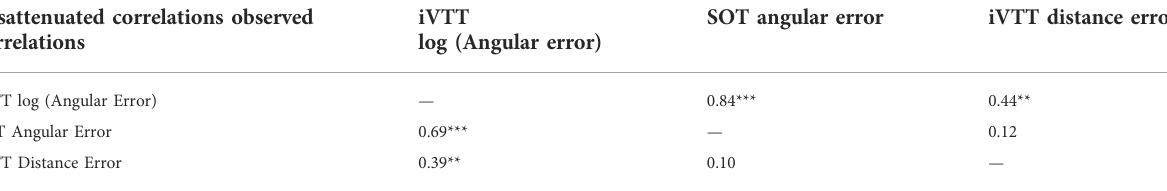
TABLE 3 Observed and disattenuated correlations for all measures at participant